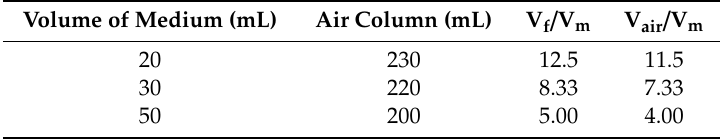
Table 1. Di ff erent air-to-liquid ratios used for the fermentation